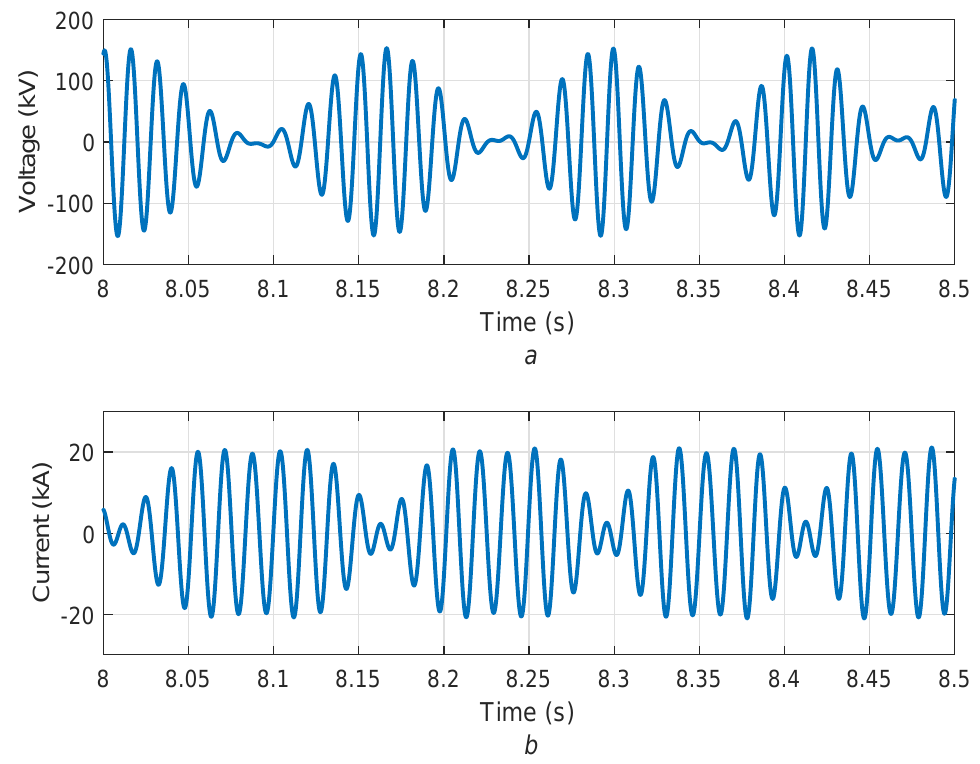
Figure 5. ( a ) Voltage and ( b ) current amplitude in power swing